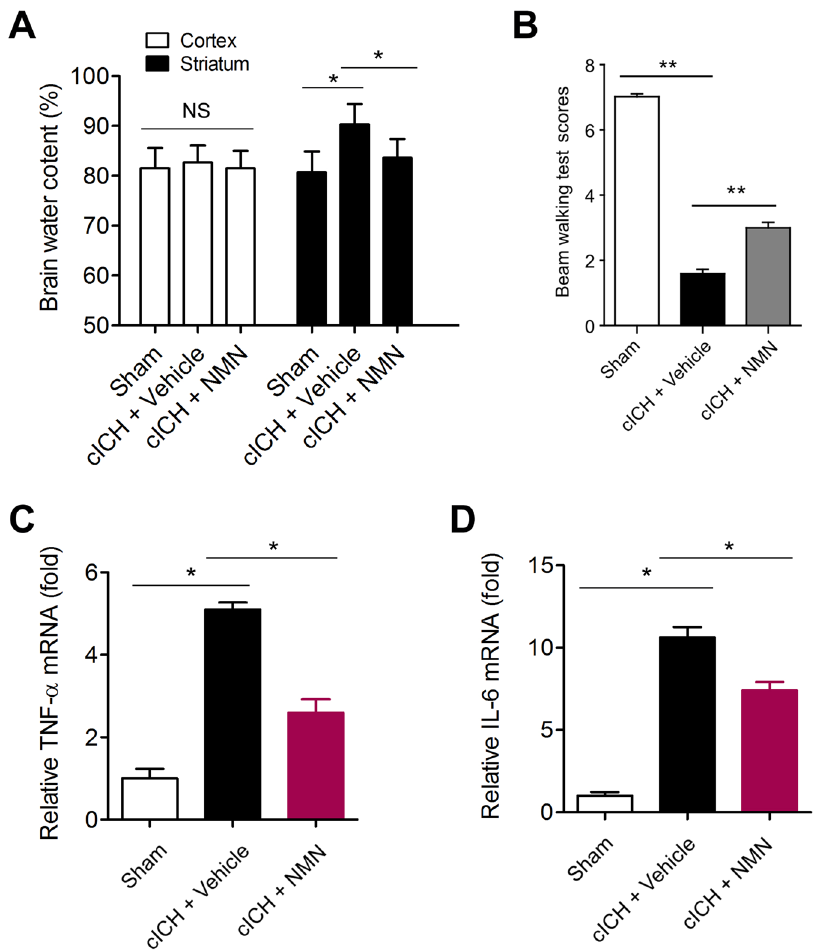
Figure 7. Effects of NMN on brain injury at 3 days post cICH in mouse model. ( A ) Brain water content at 3 days after cICH in cortex and striatum. * P < 0.05 cICH + Vehicle vs Sham, * P < 0.05 cICH + NMN vs cICH + Vehicle, n = 8. ( B ) Neurological deficit was evaluated by beam walking test at 3 days after cICH. * P < 0.05, n = 10 per group. ( C , D ) The mRNA level of TNF- α ( C ) and IL-6 ( D ) in hemorrhagic brain tissue was evaluated at 3 days after cICH by real-time PCR. ** P < 0.05. n = 6 per group.